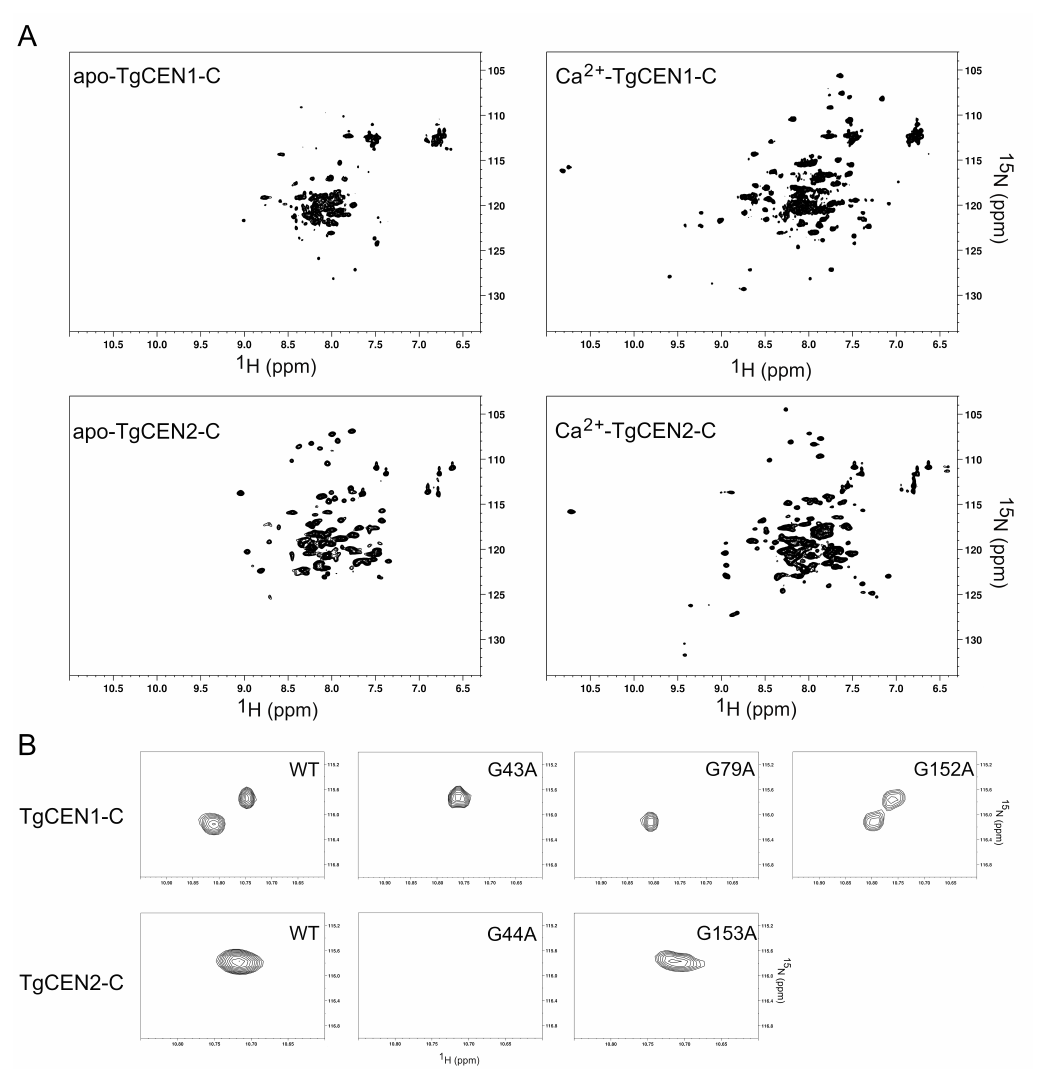
Figure 2. 1 H- 15 N HSQC NMR spectra of TgCEN1-C and TgCEN2-C. ( A ) NMR spectra of apo- or Ca 2 + -bound 15 N-labelled TgCEN1-C or TgCEN2-C. The apo-condition was obtained by adding 5 mM EGTA, while the Ca 2 + -bound condition was obtained by adding 5 mM CaCl 2 . ( B ) Downfield spectral region of 1 H- 15 N HSQC spectra showing Gly-6 peaks of TgCEN1-C and TgCEN2-C variants in the presence of 5 mM CaCl 2